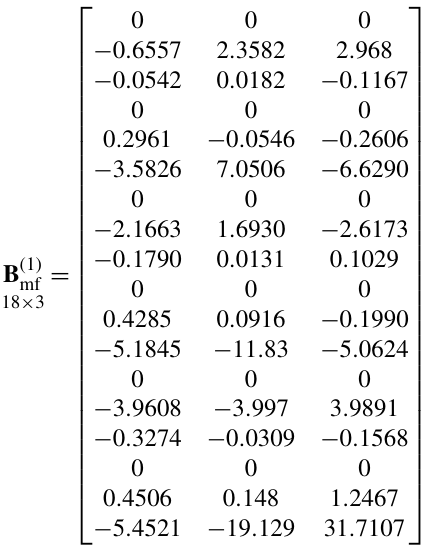
is attached with the Nacelle, to measure the induced acceler- ation, which can be integrated twice to obtain the displace- ment, see Yin et al. (2012).